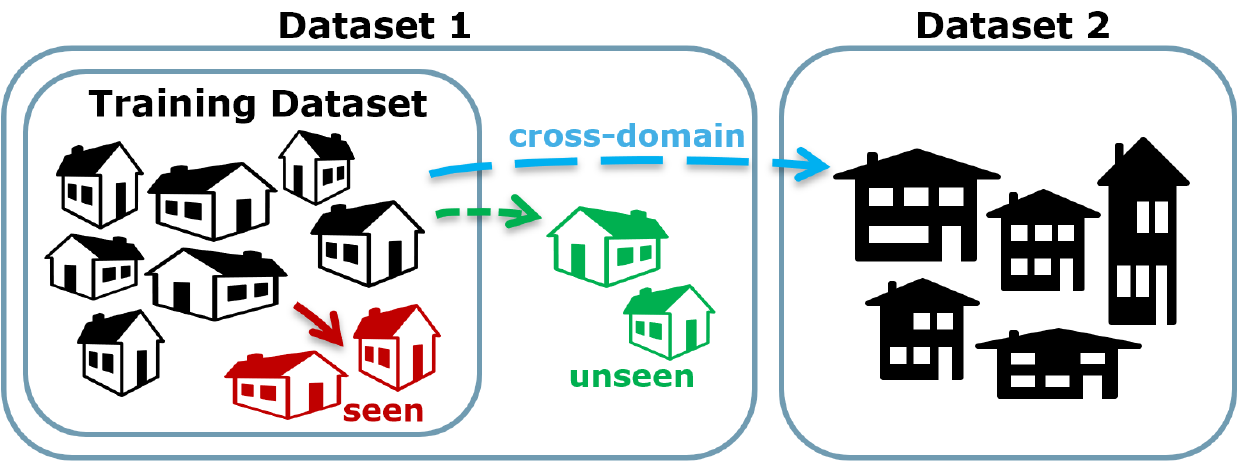
Figure 2. Different NILM evaluation scenarios: seen : the algorithm is evaluated on new data from a house that was already available during training; unseen : the algorithm is evaluated on data from a house not seen during training; cross-domain transfer learning : the algorithm is evaluated on data from a different